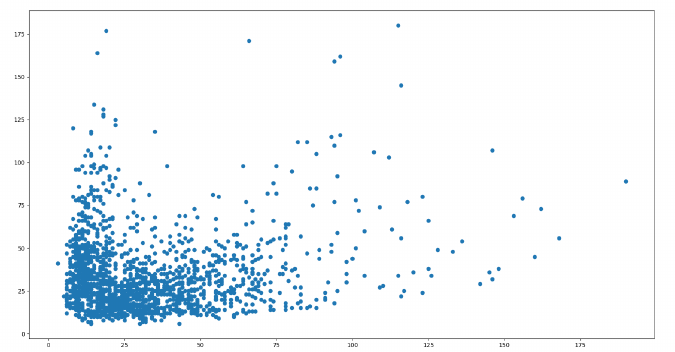
Figure 11. Height–width distribution of the bounding